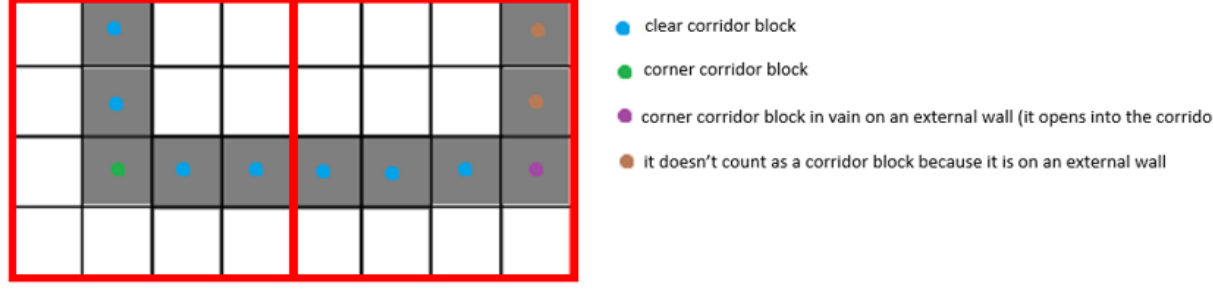
Figure 11. Examination of the atrium